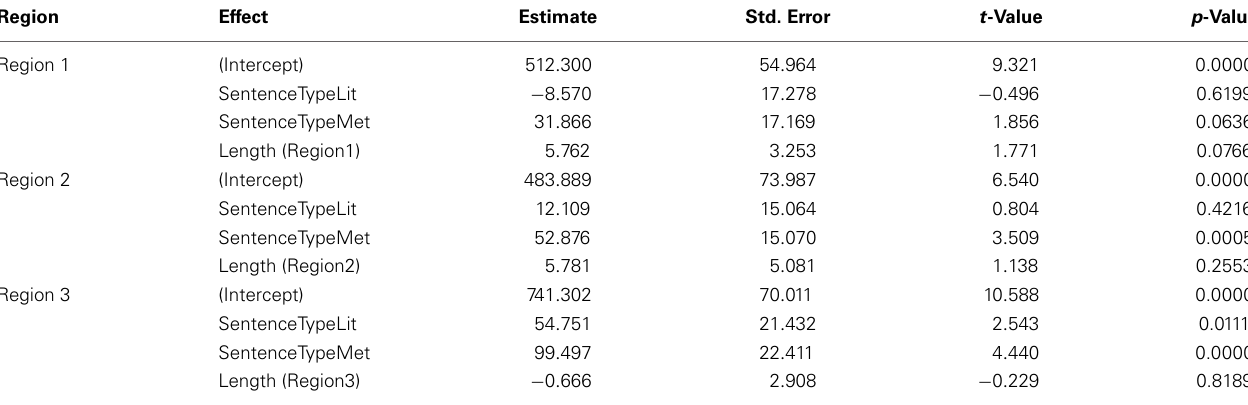
Table 2 | Model estimates and statistics for analysis by Sentence Type from Experiment 1.